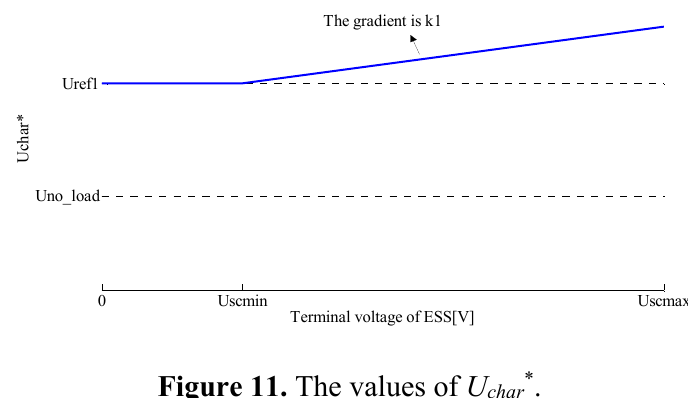
Figure 11. The values of U char * .